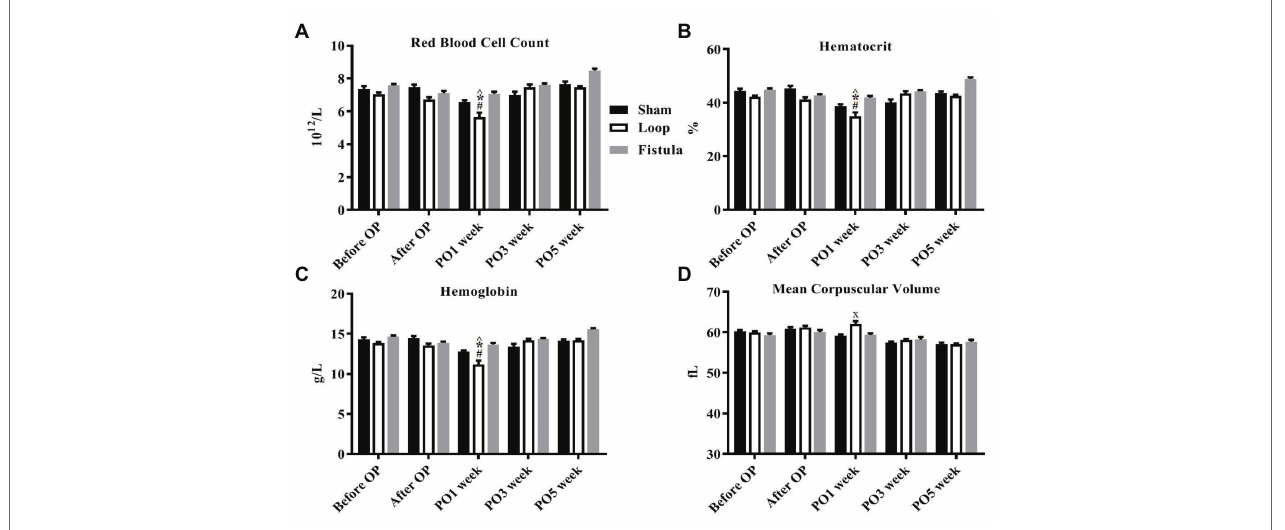
FIGURE 2 | Changes of selected hematological values. (A) Red blood cell count; (B) hematocrit; (C) hemoglobin; and (D) mean corpuscular volume. n = 10, mean ± SEM, ^ p < 0.05 vs. sham before operation, * p < 0.05 vs. loop before operation, # p < 0.05 vs. fistula before operation, x < p 0.05 vs. loop and fistula on the PO1 week.